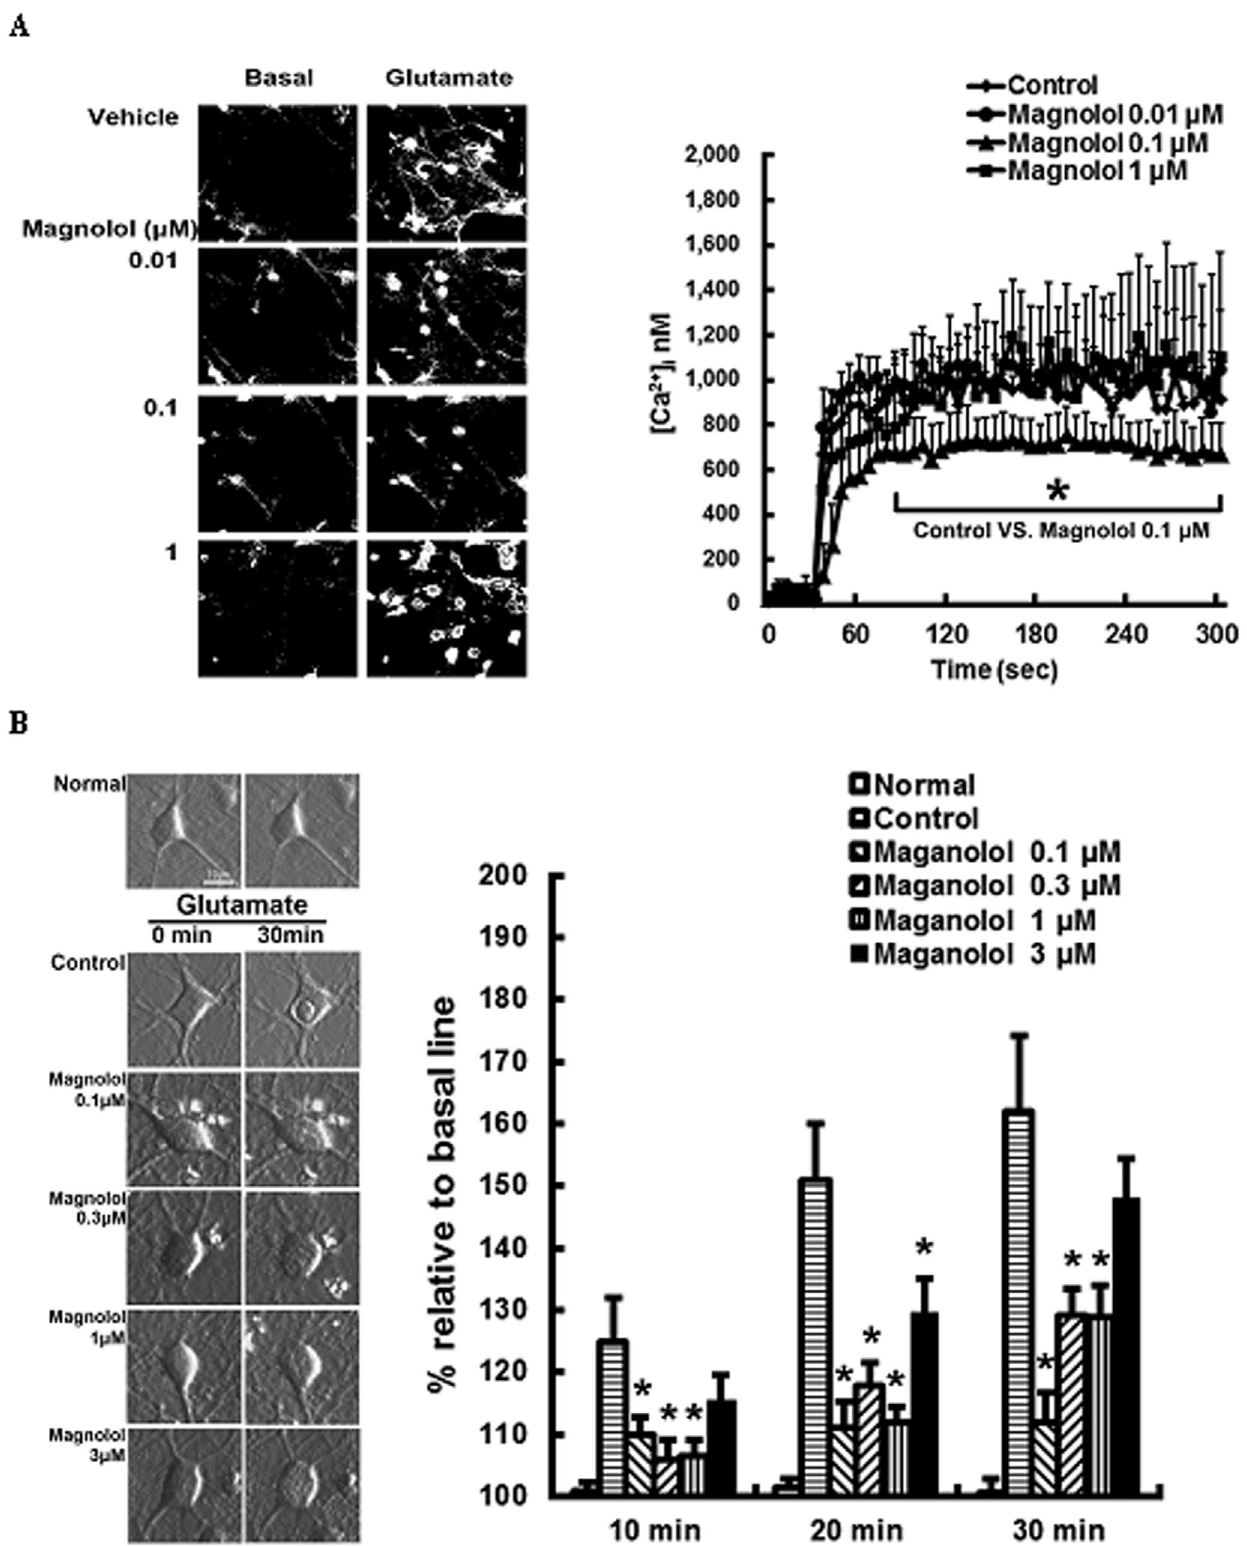
Figure 2. Magnolol attenuated glutamate-induced rises in the intracellular calcium, [Ca 2 + ](i), inflow and cell swelling in cultured neurons. (A) Ratio image detection for [Ca 2 + ](i) concentrations showed that magnolol at 0.1 m M, but not at 0.01 and 1 m M, effectively inhibited the rises of [Ca 2 + ](i) induced by glutamate exposure. (B) Time-course differential interference contrast (DIC) photomicrographs of cultured neurons showed that magnolol at 0.1–1 m M attenuated the glutamate-induced cell swelling over time. * P , 0.05 vs controls, and n =6–7 per group.